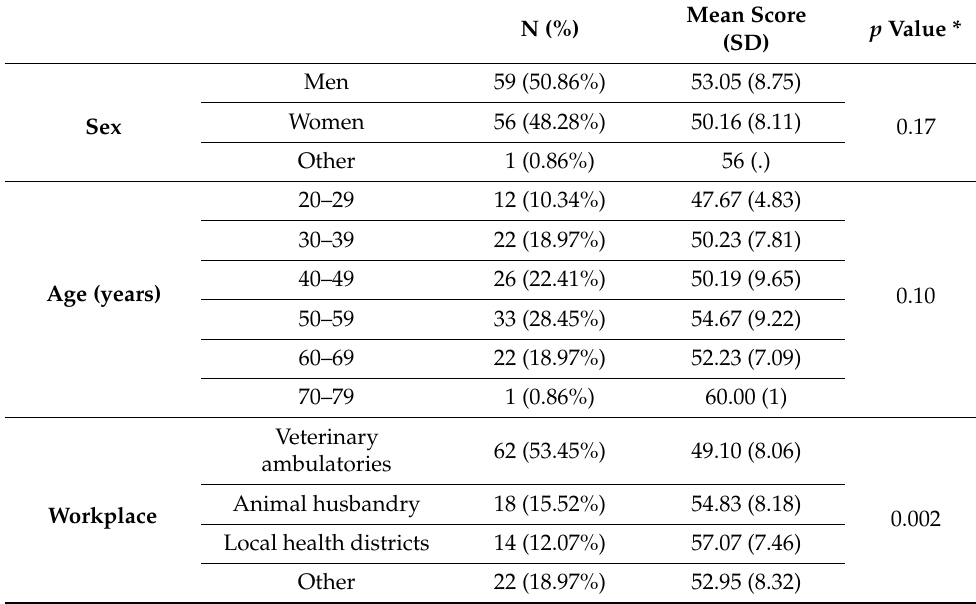
Table 2. Sample characteristics and score